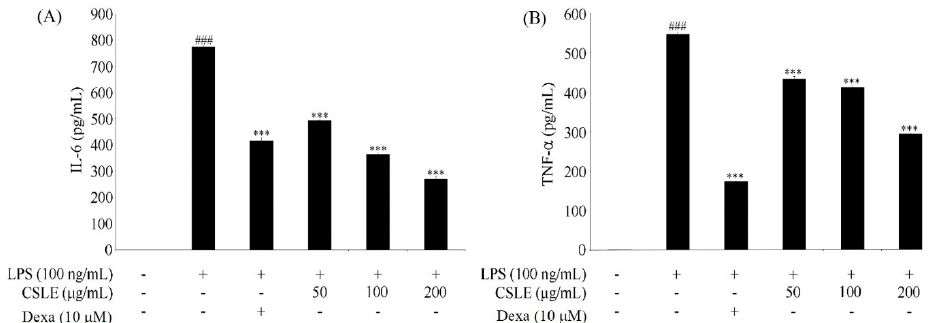
Figure 3. Pro-inflammatory cytokine inhibitory effects of CSLE in LPS-stimulated RAW 264.7 macrophages. Cells were pretreated with CSLE (50, 100, and 200 μ g/mL) for 1 h before exposure to LPS (100 ng/mL) for 18 h ( A ) IL-6, and 3h ( B ) TNF- α . The IL-6 and TNF- α were detected using ELISA. Results are expressed as mean ± SD from three independent experiments. ### p < 0.001 compared to control, and *** p < 0.001 compared to LPS alone.